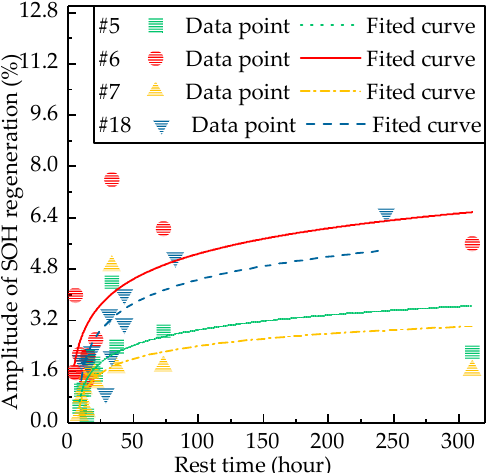
Figure 4. The relationship between rest time and the amplitude of the SOH